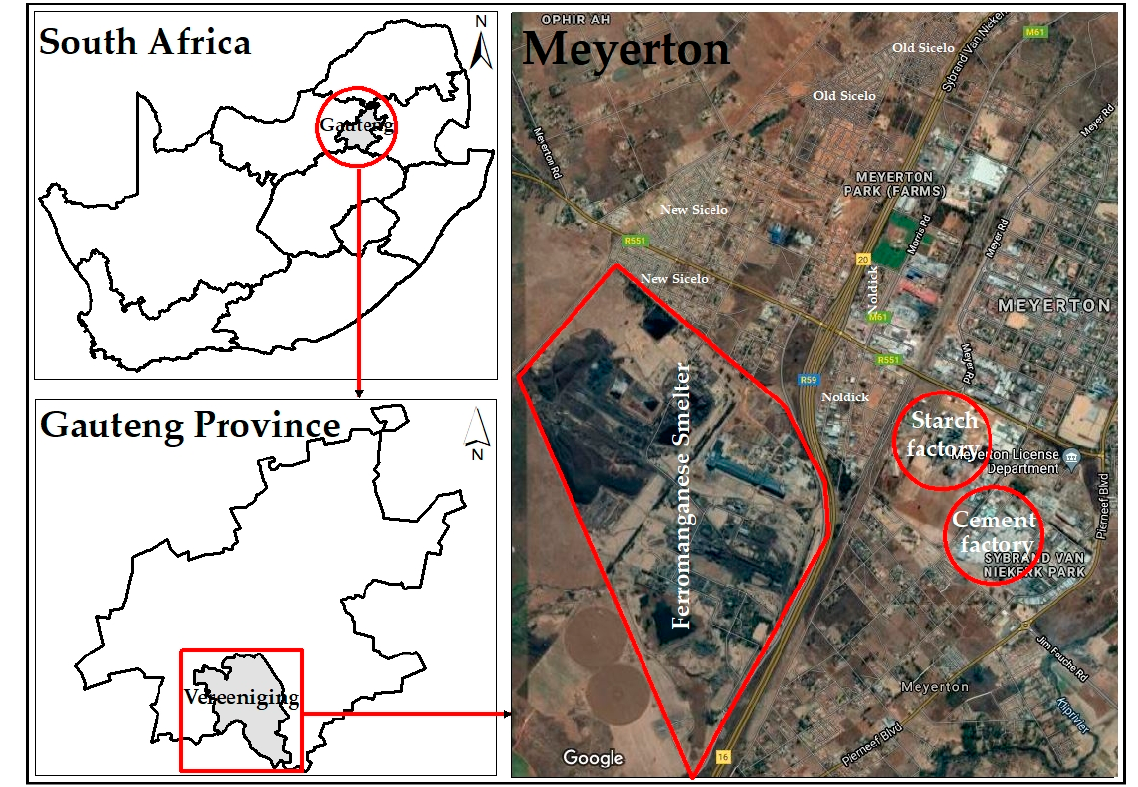
Figure 1. Geographical map of the study area (created using Google earth map (Mountain View, CA, USA) and Arcmap version 10.8 (Esri, Redlands, CA, USA)).